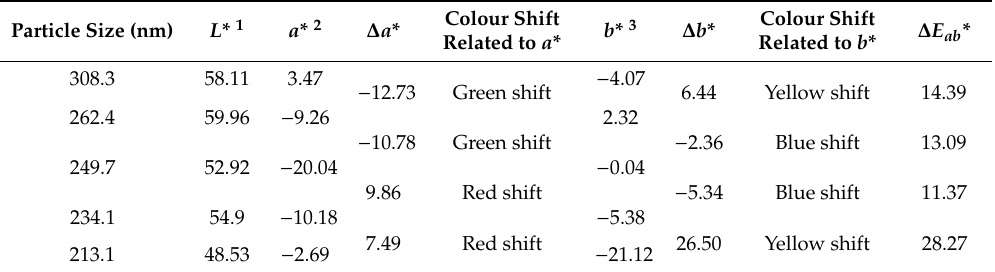
Colour coordinates ( CIE L *, a *, b *) for Poly(St-MMA-AA) / PCFs as a function of Poly(St-MMA-AA) particle diameters.